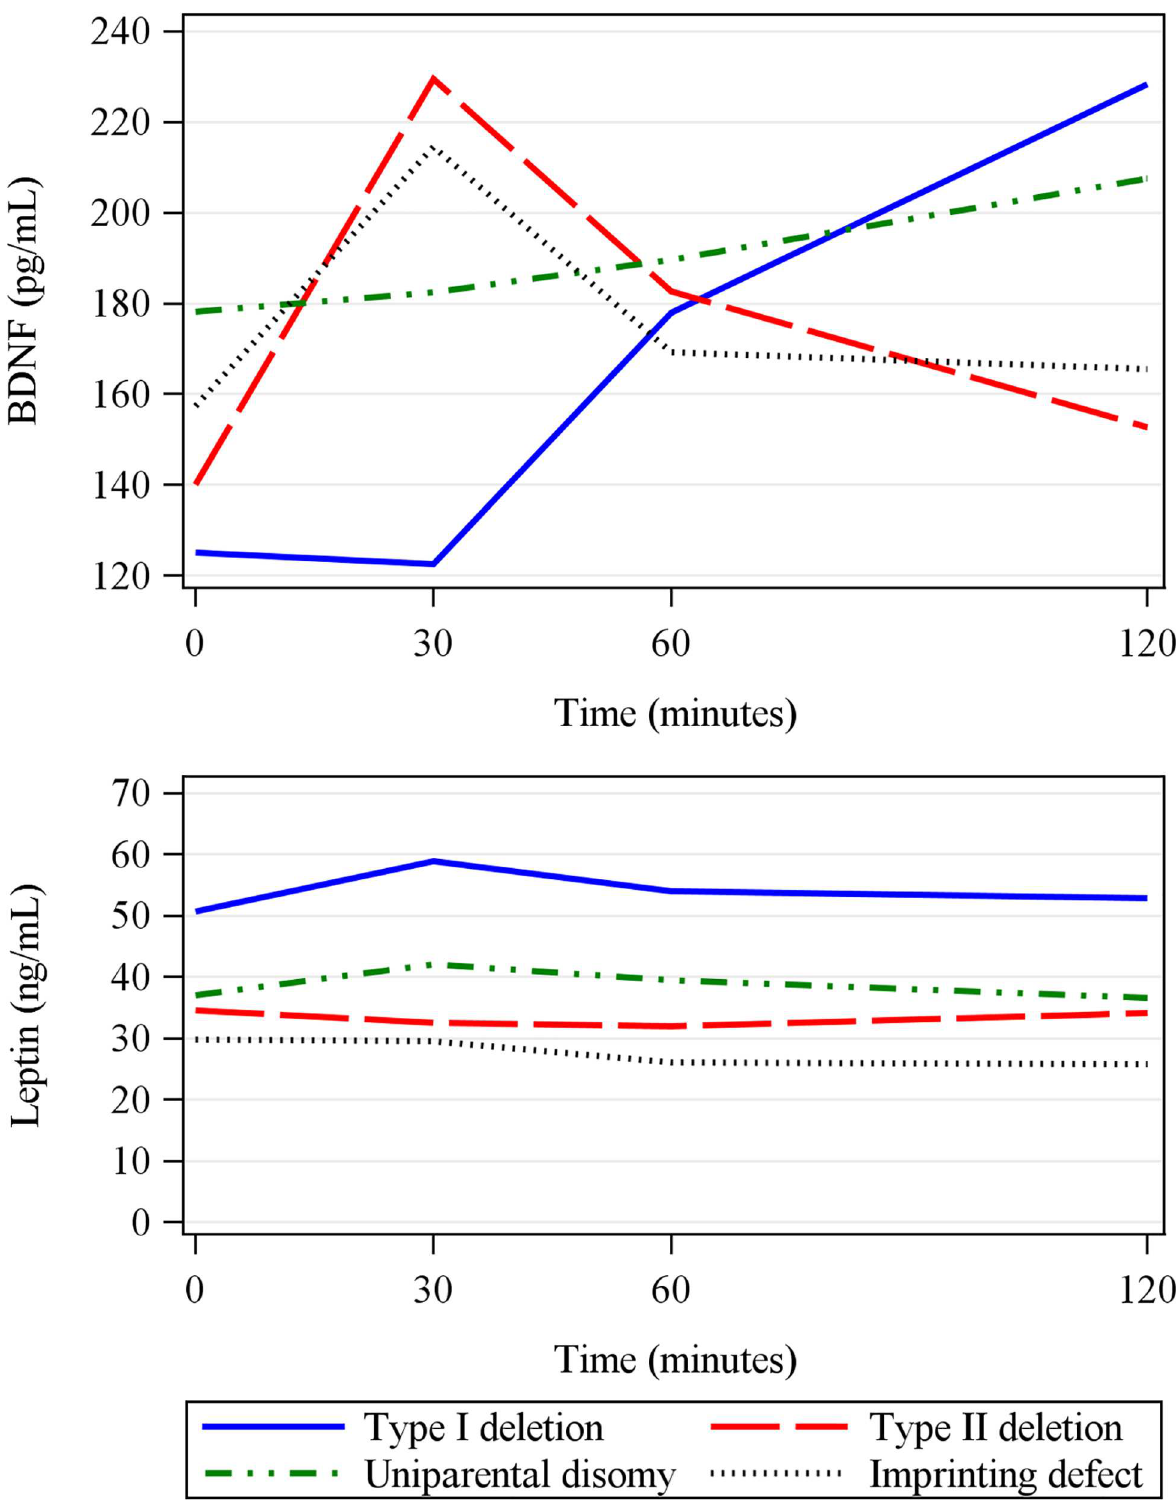
Fig 5. Baseline and postprandial Brain-derived neurotrophic factor (BDNF) (A) and leptin (B) levels in plasma by genetic subtype. Note that uniparentaldisomy is the only genetic subtype with sustainedBDNF levels.